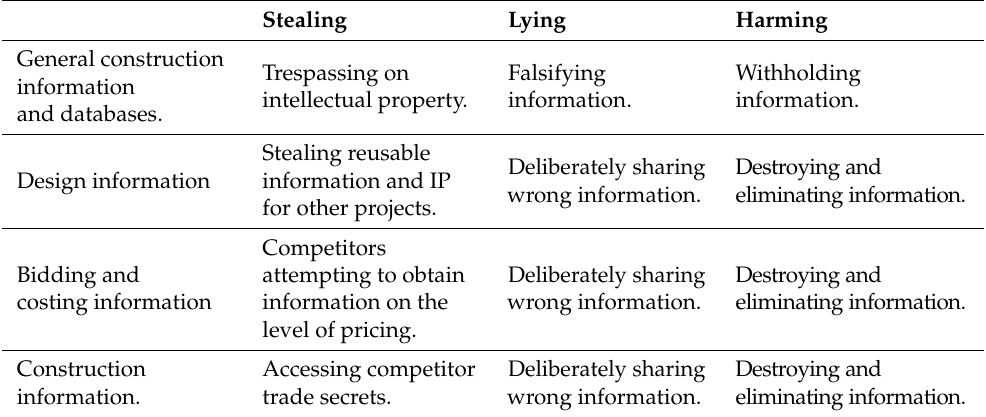
Table 6. Vulnerabilities of construction data [65]. Reprinted/Adapted with permission from Reference [65].